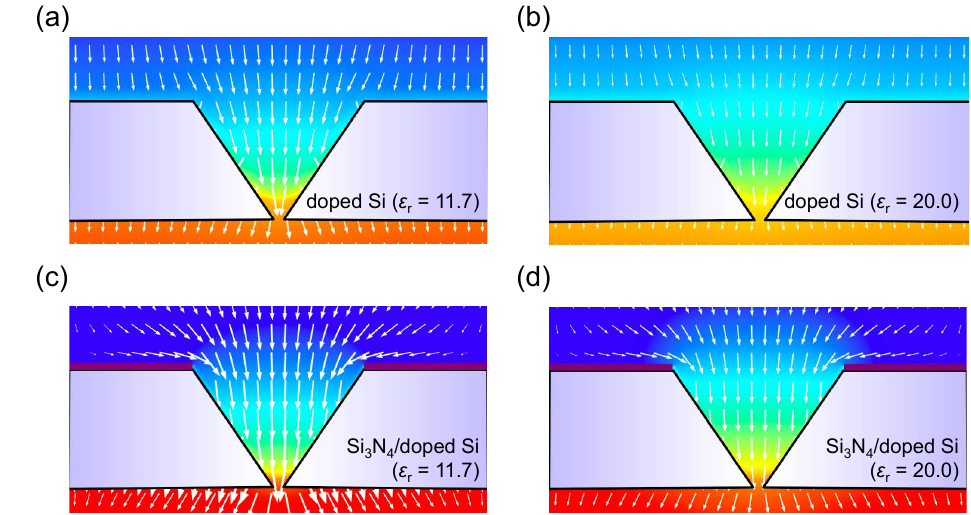
Figure 4. Simulation results of the vectors of the force felt by a negative charged analyte, which are the opposite directions of the electric field, in nanopore devices. ( a ) Doped Si ( ε r = 11.7). ( b ) Doped Si ( ε r = 20). ( c ) Si 3 N 4 /doped Si ( ε r = 11.7). ( d ) Si 3 N 4 /doped Si ( ε r = 20). Si 3 N 4 layer changes the orientation of the vectors near the Si 3 N 4 layer surface in the direction of the IP-shaped nanopore.